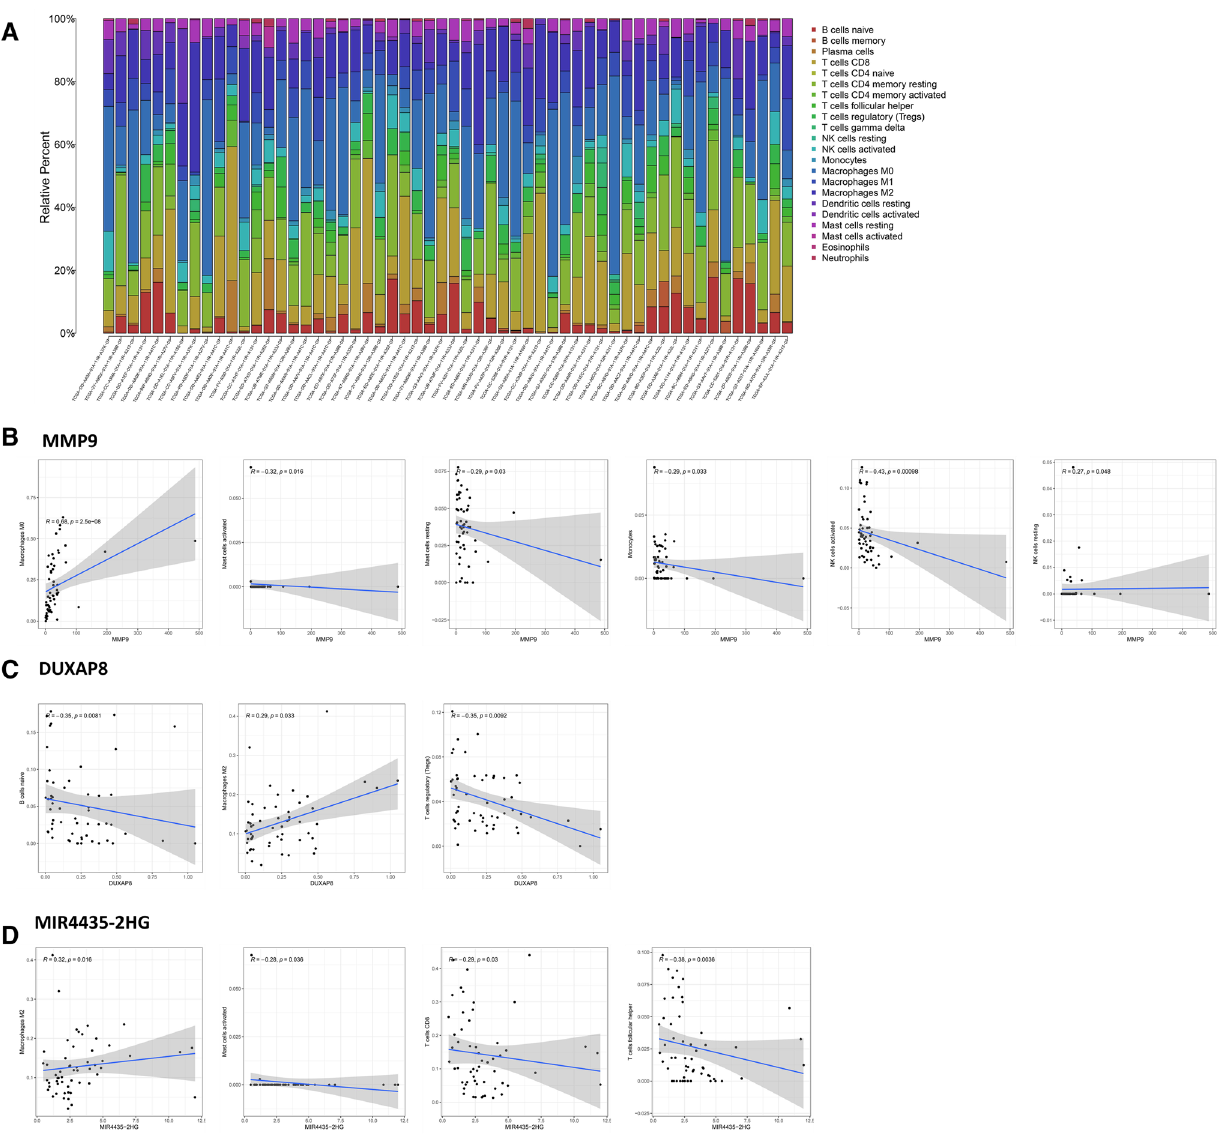
Fig. 6 Correlation of the ceRNA network axis with tumor immune cells. a Proportion of 22 tumor immune cells in TCGA liver cancer samples (n = 56). Scatter plot showing the correlation of MMP9 ( b ), DUXAP8 ( c ), and MIR4435-2HG ( d ) with tumor immune